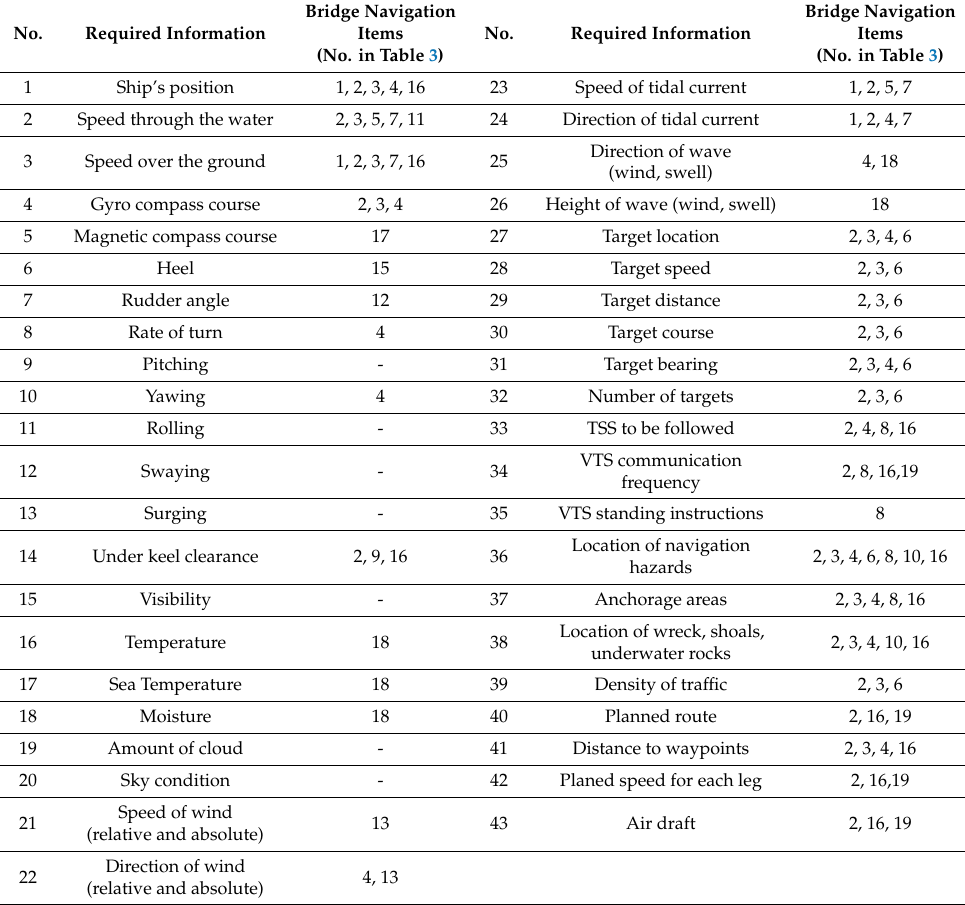
Table 4. Linkage between required information for Level 1SA and information resources (bridge navigation